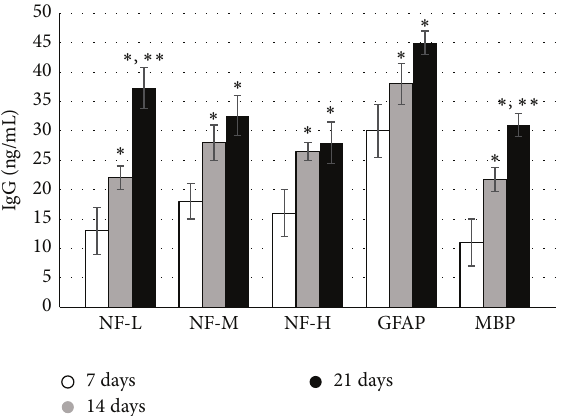
Figure 2: Serum titers of IgG against neurotypic (NF) and gliotypic (GFAP and MBP) proteins in hens ( 𝑛 = 7 ) administered a single dose of OPIDP-inducing phenyl saligenin phosphate (2.5mg/kg, im). Serum was collected at 7, 14, and 21 days. Mean levels of IgG ( ± S.E.) were significantly ( ∗ 𝑃 < 0.05 ) higher at 14 and 21 days compared to 7 days. With the exception of anti-NF-L and anti- MBP titers, there were no statistical differences between 14 and 21 days, suggesting peaking of the anti-NF-M, anti-NF-H, and anti- GFAP titers against these antigens. There was no detectable titer of antibodies against these antigens in control hens or in sera of hens prior to PSP administration.